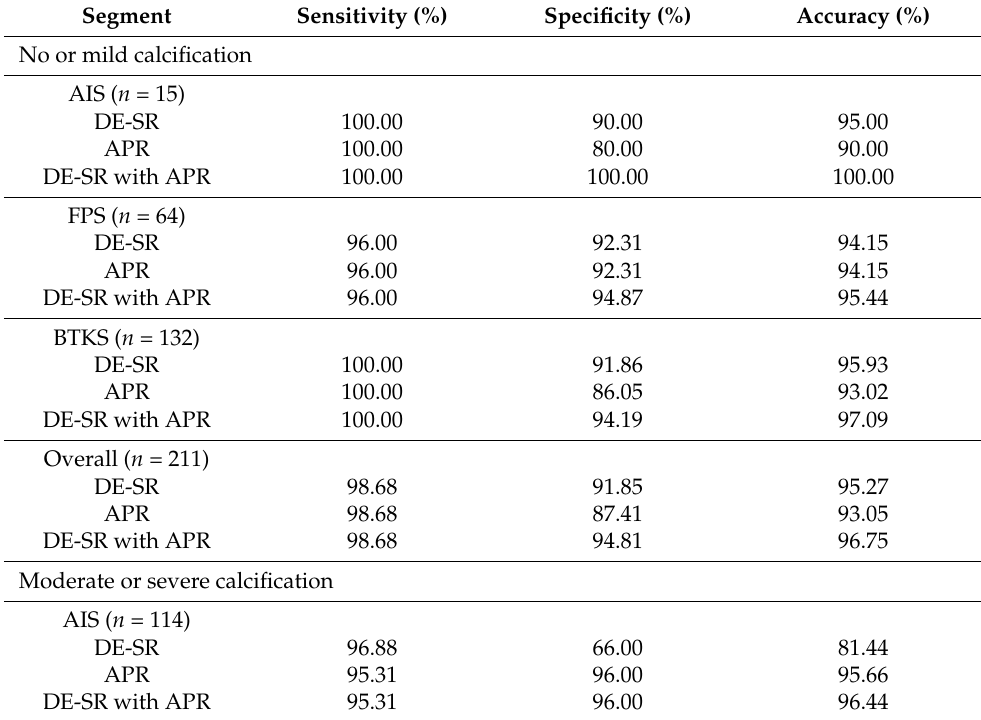
Table 5. Sensitivity, specificity, and accuracy according to vascular wall calcification and arterial